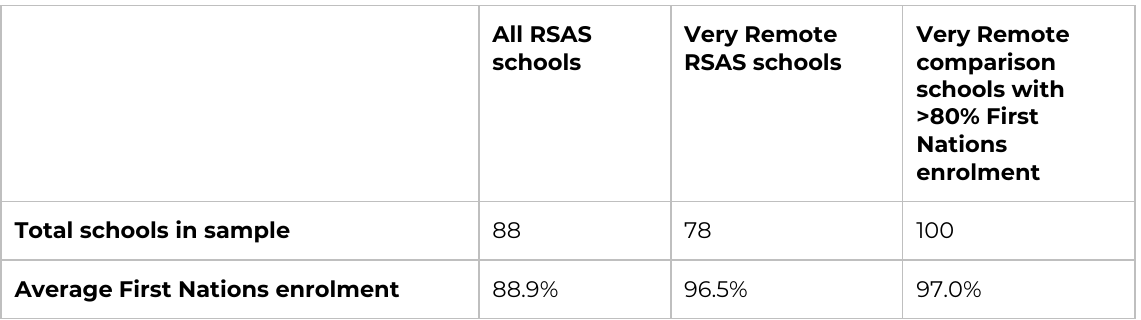
Average First Nations